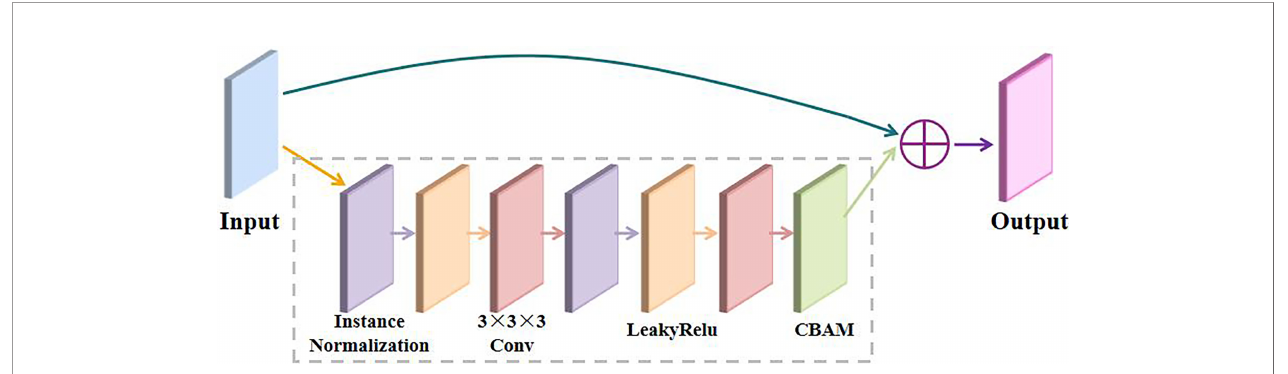
FIGURE 3 | Structure of an RA